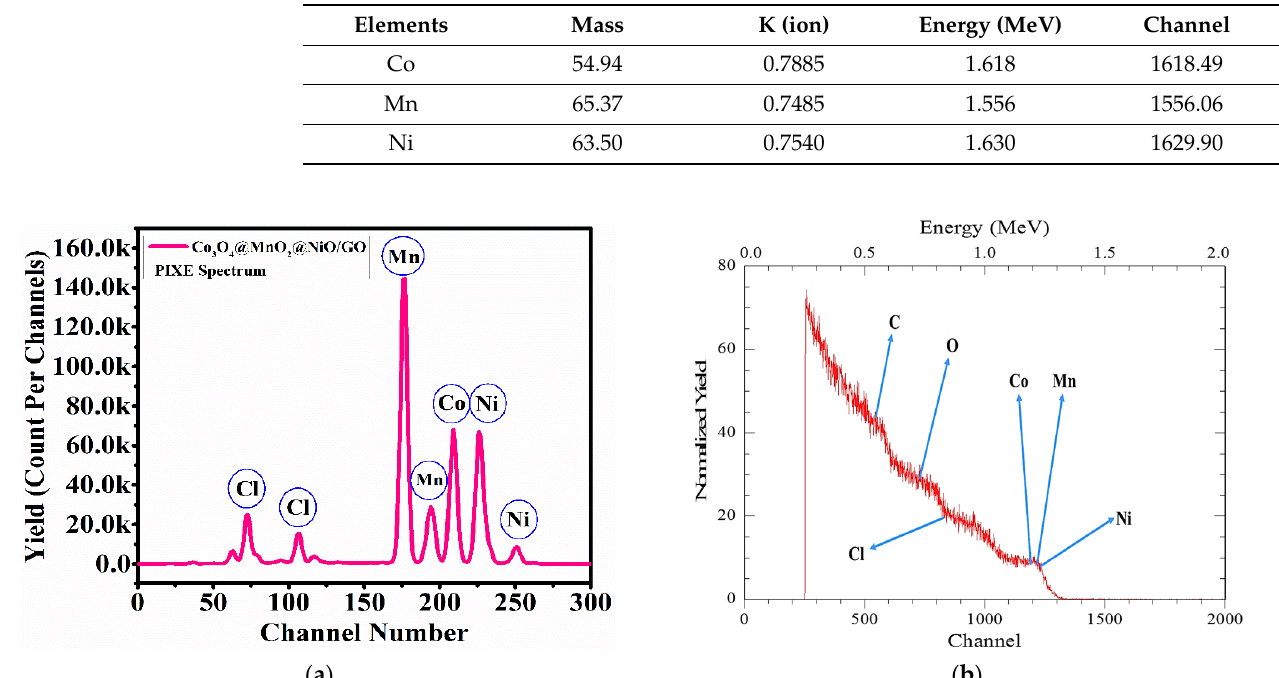
Figure 6. Spectra of (a) PIXE and (b) RBS of Pristine Co 3 O 4 @MnO 2 @NiO/GO Electrode.